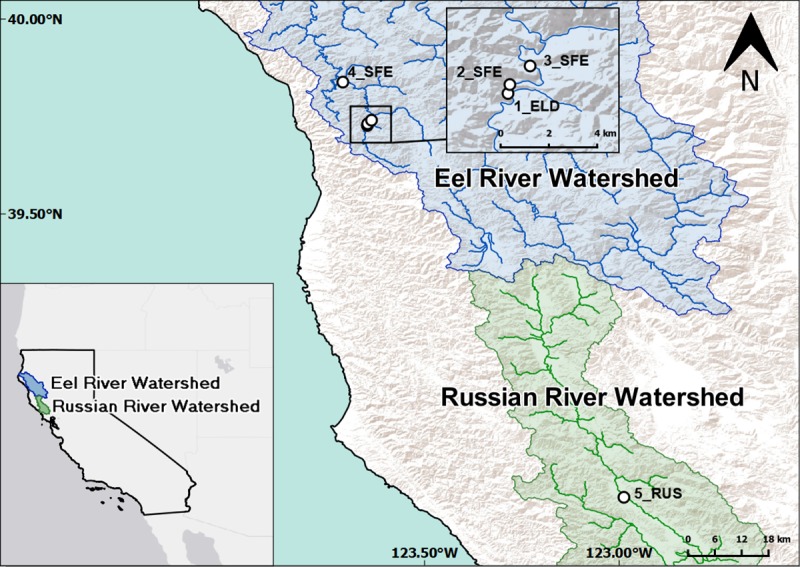
Map of sampling sites on the South Fork Eel River and on the Russian River in California, USA.Blue areas on the map refer to the Eel River watershed, while green denotes the Russian River watershed. Sites are labelled in order of increasing drainage area from 1 to 5, while the suffix refers to the river: ELD = Elder Creek, SFE = South Fork Eel, RUS = Russian River.